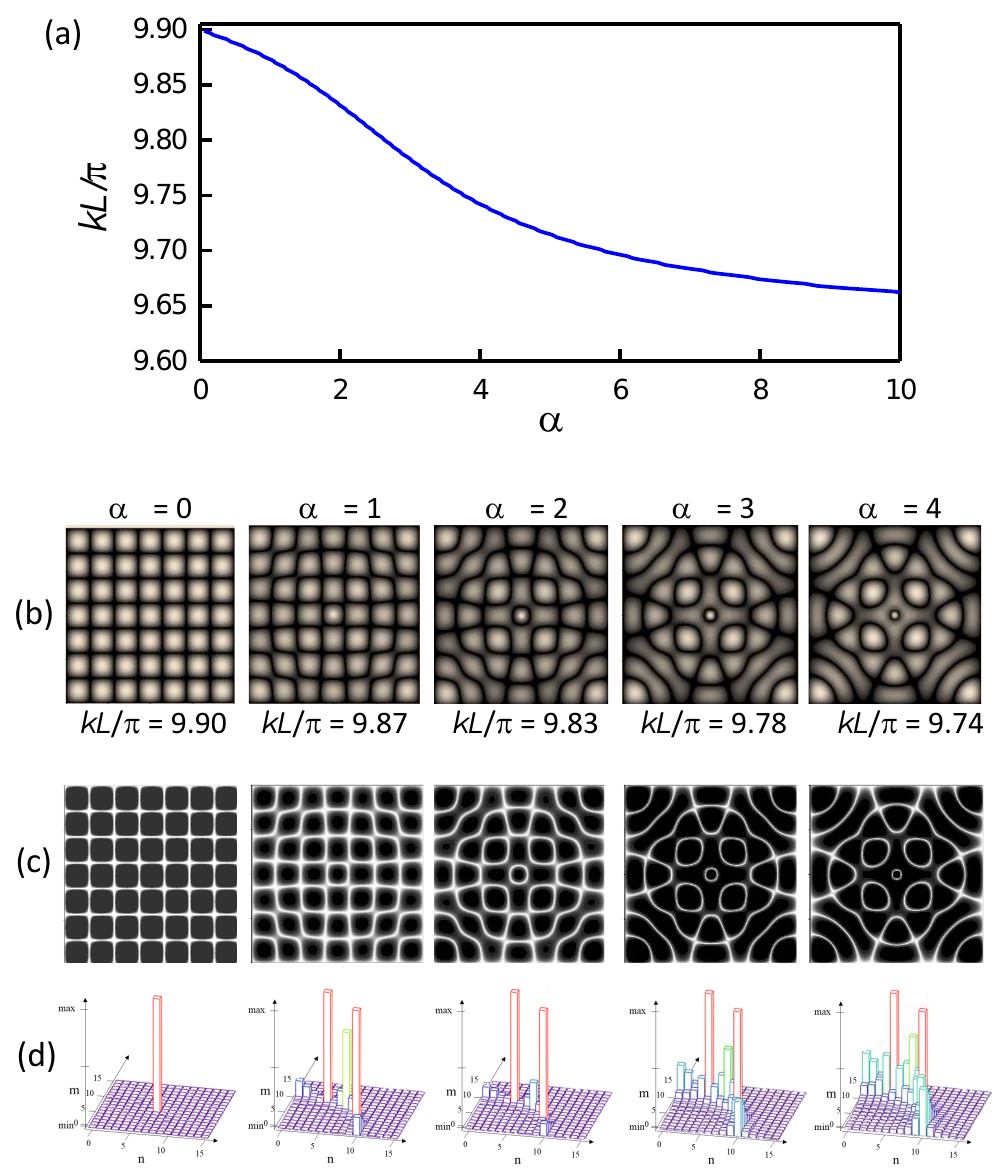
( p ) p k . ( b ) Dependence . ( b ) Dependence of the wave patterns of 7,7 7,7